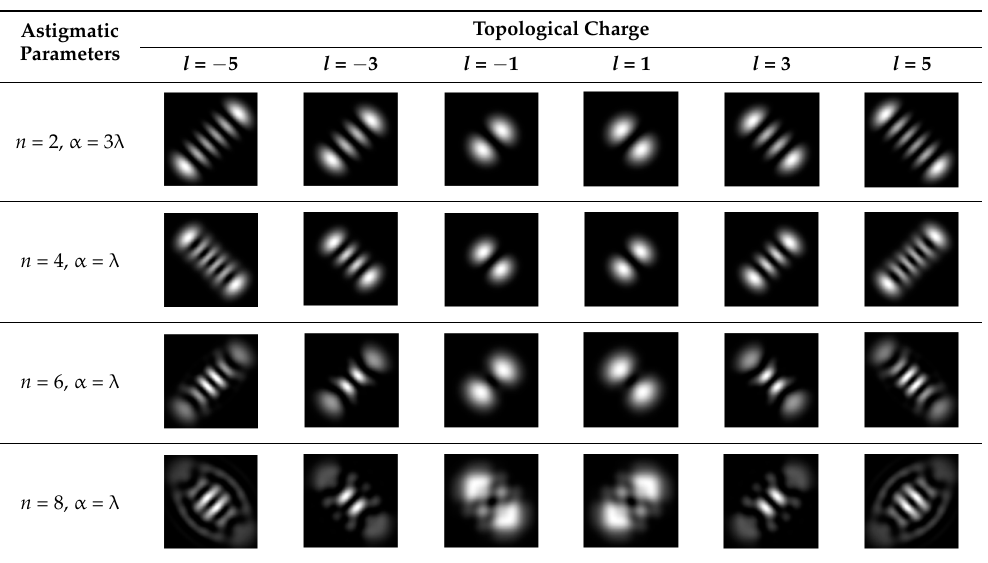
Table 3. Simulation results of astigmatic transformations of vortex beams Ψ 0, l ( r , ϕ ) with aberrations of the form exp [ ik α Z n ,2 ( r , ϕ )] in the focal plane.